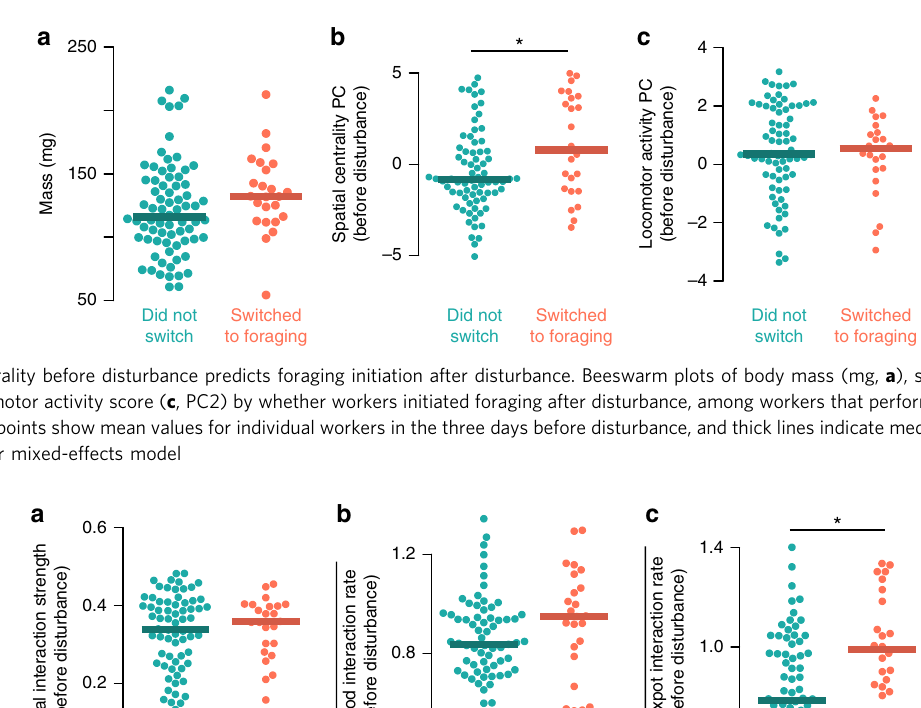
(Fig. 5a, generalized linear mixed-effects model, df = 3039, z =